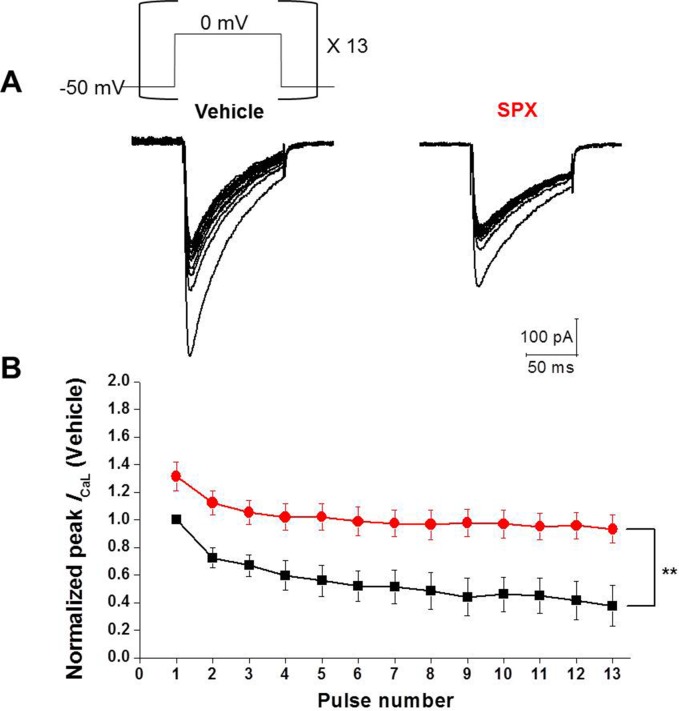
Use-dependency of SPX on ICaL.A, Repetitive application of depolarizing pulses (shape is shown in the figure inset) to 0 mV from a holding potential of −50 mV gradually decreased the ICaL amplitude. The frequency of depolarizing pulses was 2 Hz. In the presence of SPX, the gradual decrease of ICaL was significantly attenuated. B, Summary of the use-dependent effect of SPX. Normalized current levels are plotted against pulse number (A and B, n = 6; black, control; red, SPX). The amplitudes of steady-state currents of both control and SPX group were normalized by the first current of the control. *P < 0.05 **P < 0.01 (n = 6).